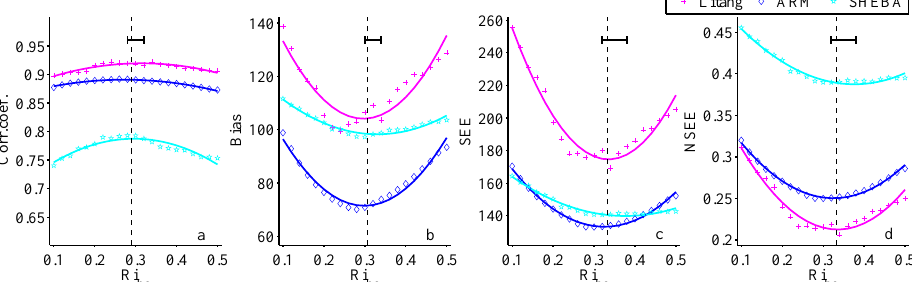
Figure 11. Comparison between estimated PBLH using the bulk Richardson number method and observed PBLHs for all types of PBLs. The correlation coefficient (a) , bias (b) , standard error (c) , and normalized standard error (d) are shown. The sounding data are taken from Litang (plus sign), ARM Shouxian (diamond), and SHEBA (pentacle). The curved lines are obtained by quadratic curve-fitting, the black vertical dashed lines indicate a representative Ri bc for all three sites, and the error bars indicate the range of Ri bc across the three sites.